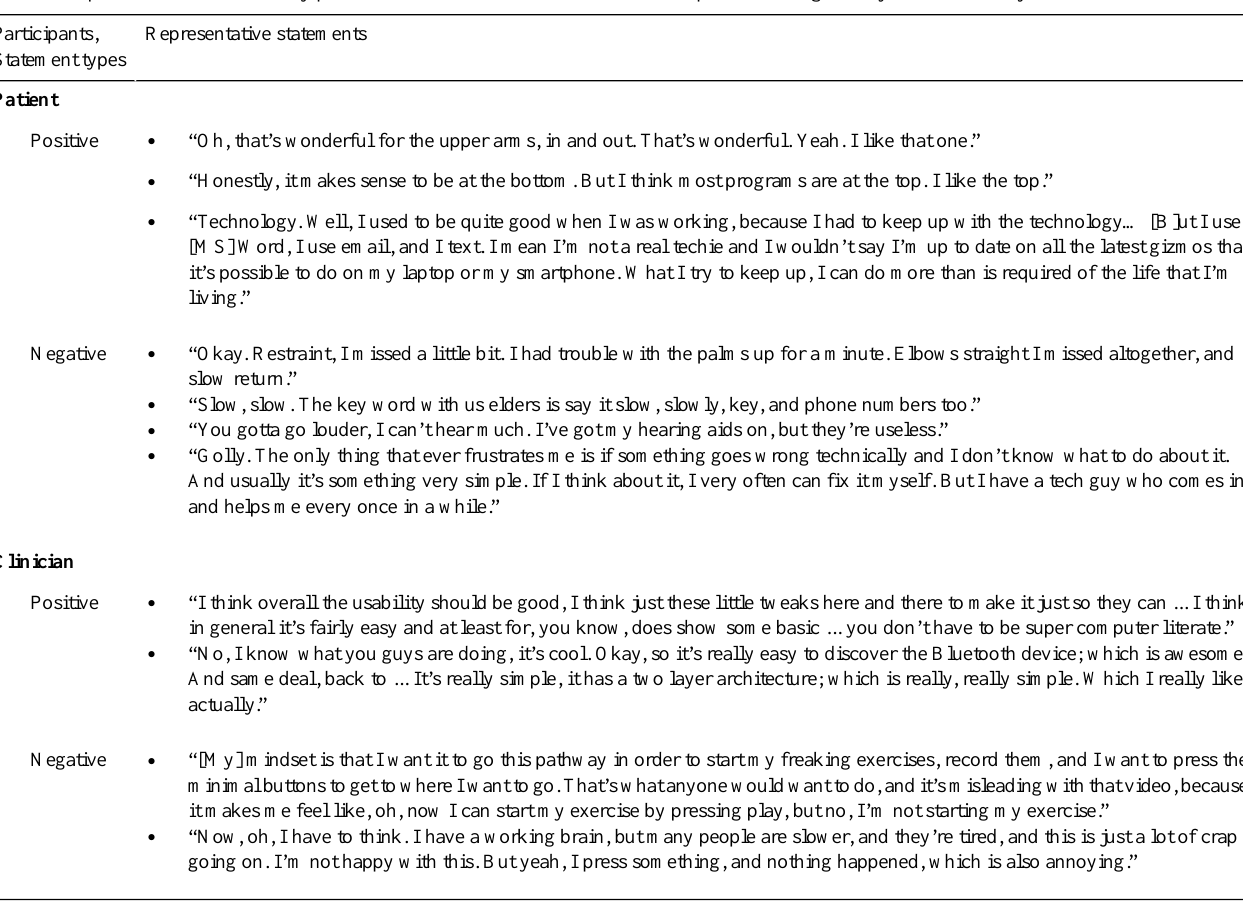
Table 3. Representative statements by patients and clinicians that were found to be positive or negative by sentiment